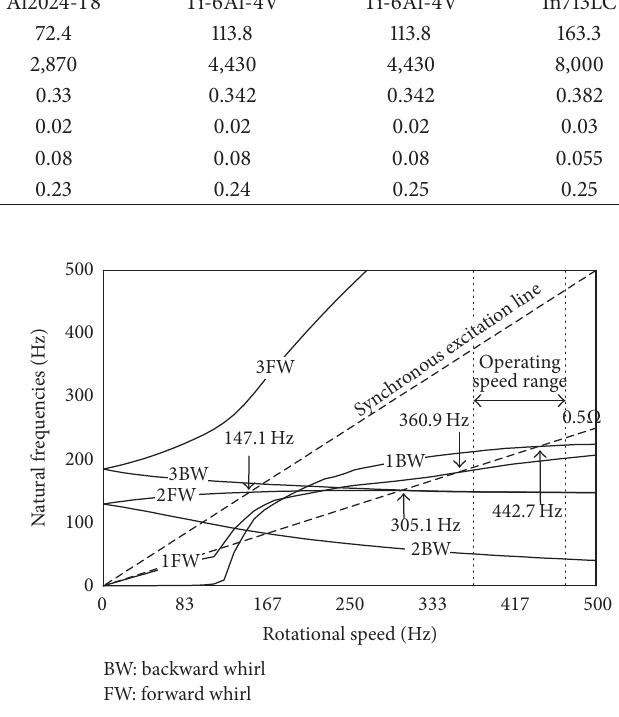
Figure 5: Campbell diagram for the radial clearance of the squeeze film damper equal to 0.08 mm.